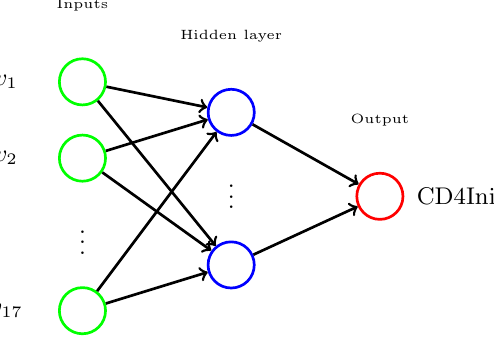
Figure 2. MLP architecture. There is a MLP per clinical endpoint; here is an example for CD4Ini. For MLP training, we use the logistic activation function, a hidden layer with 8 neurons, 2 outputs, and 10,000 epochs with the Limited-memory BFGS algorithm (the